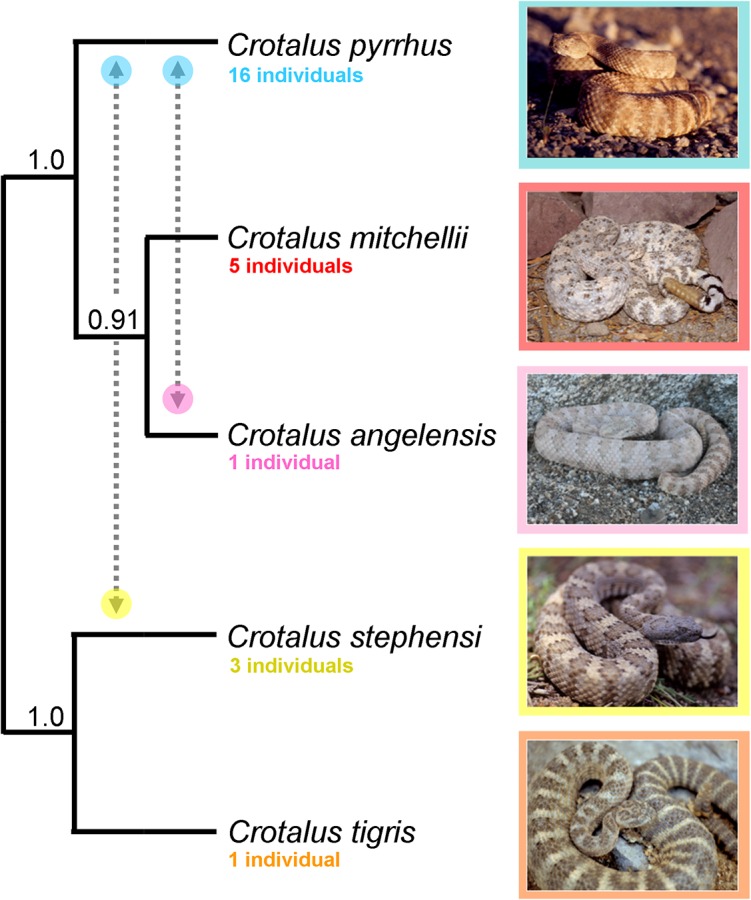
Species tree for species recognized within the Crotalus mitchellii group.The species tree was assembled using a full coalescent model applied to 2409 biallelic SNPs; support values represent proportion of trees sampled with a particular topology. Dashed lines with arrows indicate taxa for which evidence of introgression was found using Patterson’s D-statistics. Photograph of C. mitchellii by M. Ingrasci.